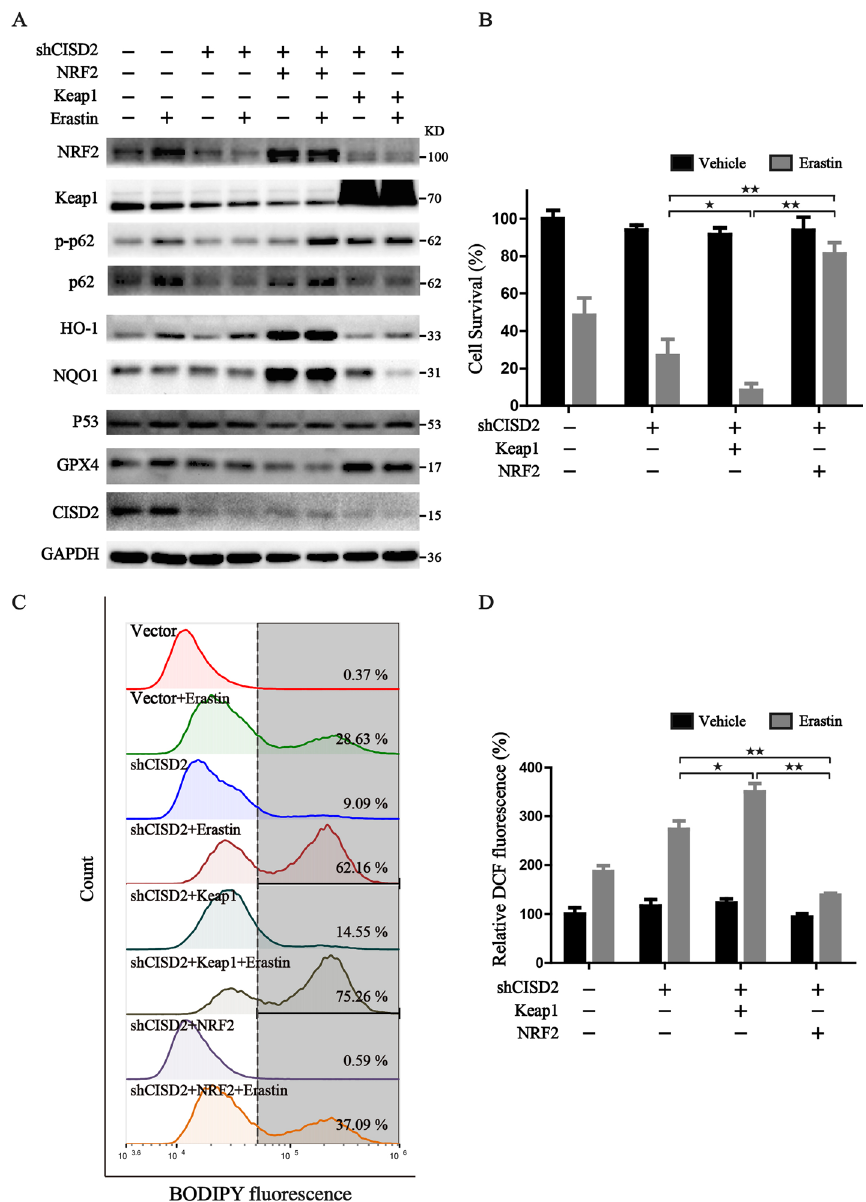
Fig. 4 The p62–Keap1–NRF2 pathway is involved in shCISD2-mediated ferroptosis. A Western blot analysis of the expression of proteins associated with the p62–Keap1–NRF2 pathway and ferroptosis in HT-1080 cells; GAPDH was used as loading control. B Cell viability assay in the indicated cells with or without Erastin treatment; cell viability in control cells was defined as 100%. C Representative images from flow cytometry for the detection of lipid peroxides by BODIPY staining in the indicated HT-1080 cells with or without Erastin treatment (7.5 µM). D Statistical graph of DCF fluorescence from microplate reader to detect the cellular ROS in the indicated HT-1080 cells with or without Erastin treatment (7.5 µM); ★ P < 0.05 and ★★ P < 0.01 between the indicated